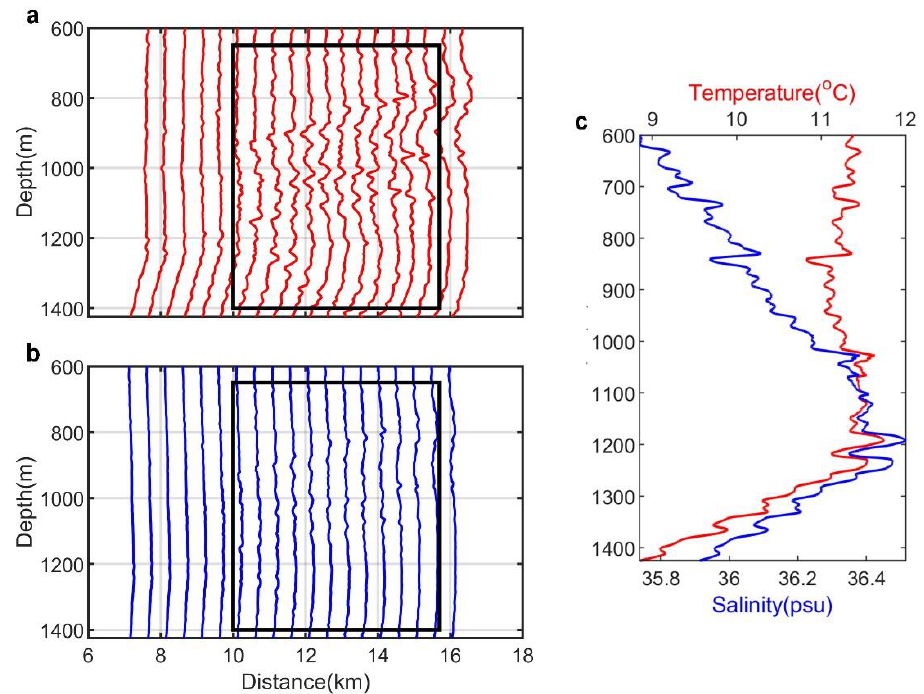
Figure 11. ( a ) Inverted temperature and ( b ) salinity profiles at the left edge of the meddy. Signs of thermohaline intrusions are circled by black rectangles. The inverted temperature and salinity sections have been laterally smoothed using a 500 m window in order to suppress the noisy and random subtle picks due to the ringyness of seismic data. ( c ) A pair of temperature and salinity profiles at the same location in this region show that warm (cold) intrusions are also salty (fresh). The diffusivity K sides T